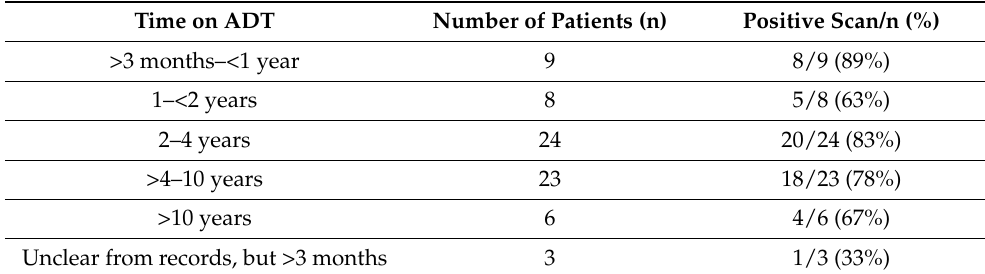
Table 4. Detection rate stratified by time on ADT. Time on ADT Number of Patients (n) Positive Scan/n